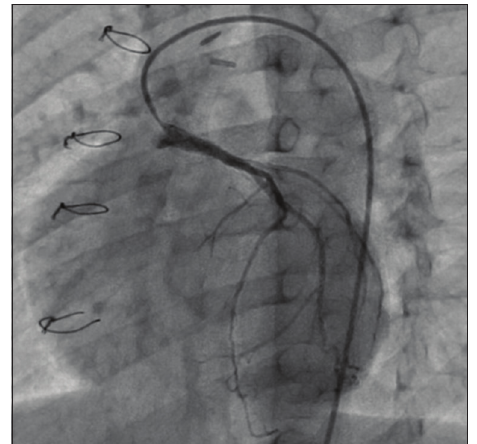
FIGURE 1. Coronary angiogram shows the left coronary artery 28 months after the reimplantation of anomalous origin of the left coronary artery from the pulmonary artery to aortic root and stent placement in the left main coronary artery. The complete resolu- tion of flow in the left coronary artery is accomplished and no signs of in-stent stenosis are